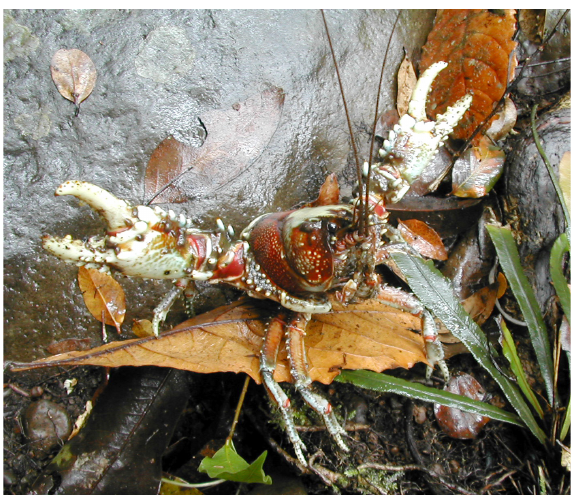
Image 1. Mountain Crayfish Euastacus sulcatus in natural habitat (23.iv.2003, © Jason Coughran, Brindle Creek).